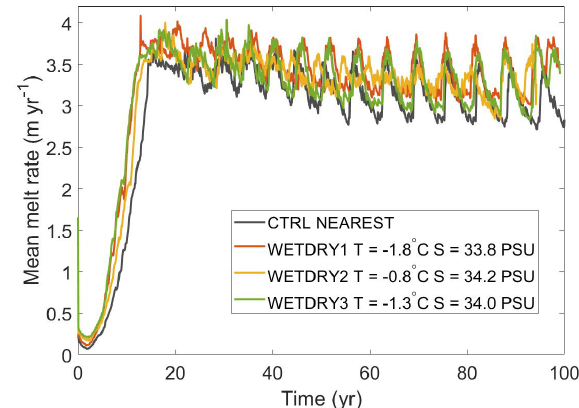
Figure A5. Mean melt rate and the row index of new grounding line (GL) from (a) CTRL and (b) Ocean3. The row index of initial GL is 0.